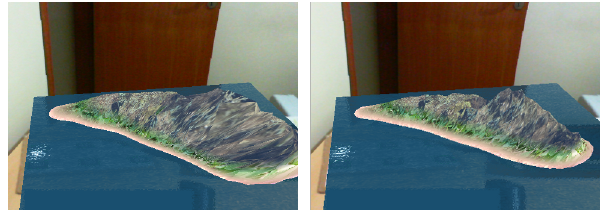
Fig. 4. Example of an abrupt terrain generated to the left, and the fixed terrain to the right.